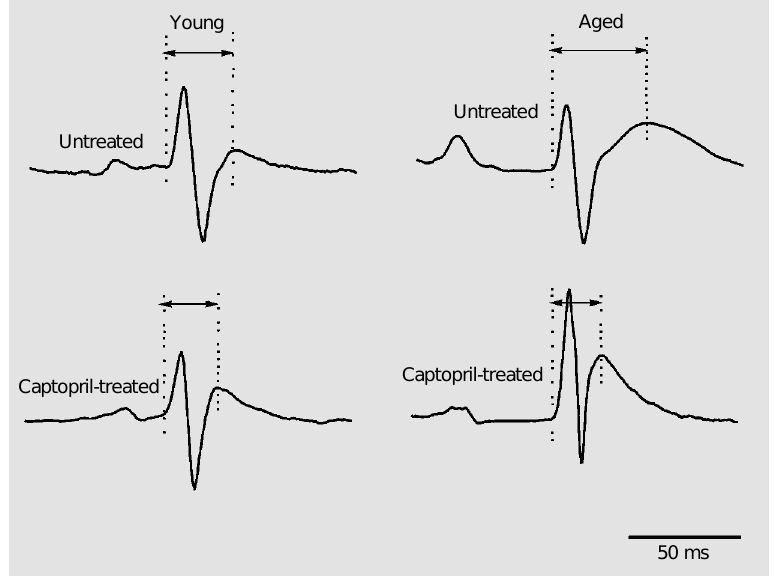
Figure 1. ECG tracings of representative rats of each experimental group. The arrows indicate the length of the QT interval. Notice the enlargement of the QT interval in untreated aged rats and the reduction of the QT interval in captopril treated aged